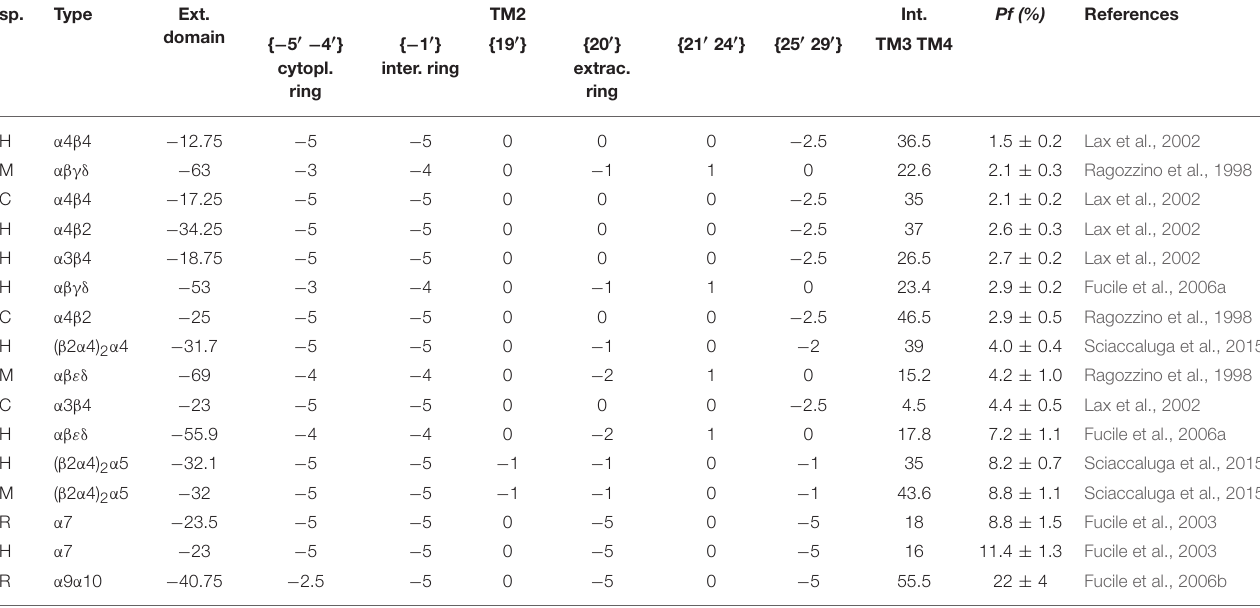
TABLE 2 | Charge distribution and measured Pf- values of the indicated 16 nAChRs.